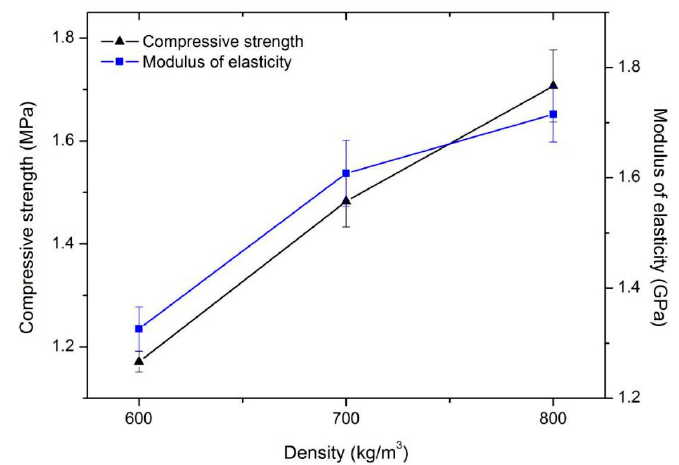
Figure 3. Compressive strength and modulus of elasticity of series I mixtures.